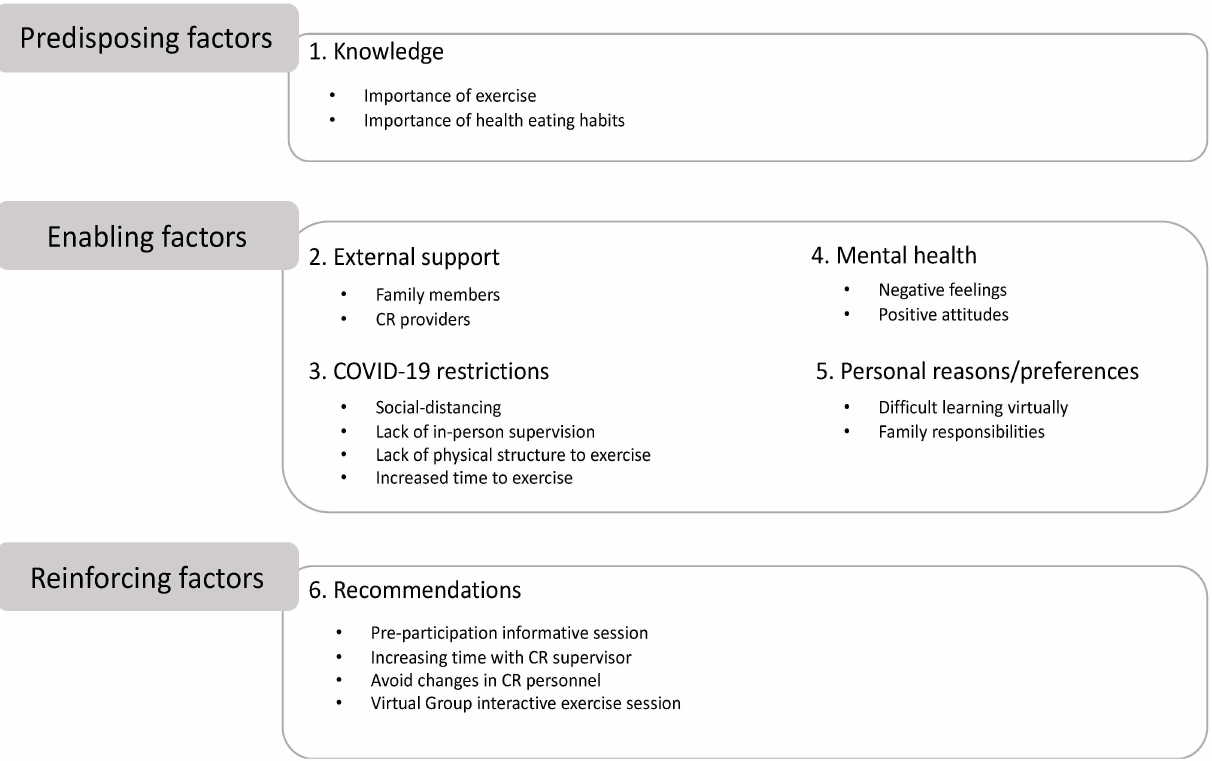
Figure 3. Summary of the focus groups themes and subthemes extracted using the PROCEED- PROCEED model. Abbreviations: COVID-19 = coronavirus 2019; CR = cardiac